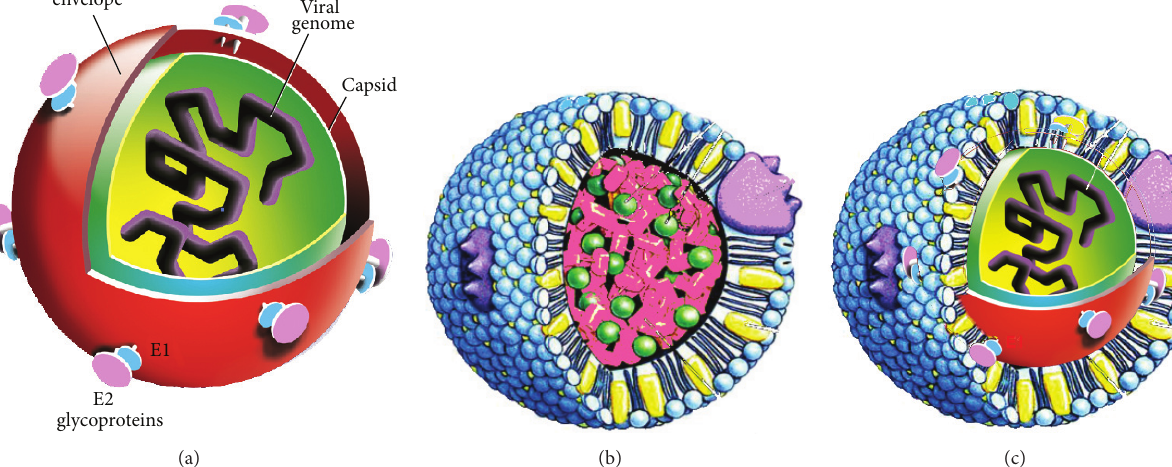
F 1: Schematic representations of the hepatitis C virus. (a) In the absence of three-dimensional structures of the virion or any of its structural proteins (the envelope proteins E1-E2 and the core protein), HCV is represented roughly as a sphere without any symmetry. e E1- E2 glycoproteins (blue and pink, resp.) are set in the viral envelope (red) via their transmembrane domains. eir distribution at the particle surface is le loose on purpose, since currently available high resolution cryo-TEM (transmission electron microscopy) examinations did not show any high-density layer of proteins on the lipid envelope [23, 24]. e internal layer is formed by the core protein (green) compacting the viral RNA genome (black); no structural information is available about the nucleocapsid and its arrangement (illustration by J.-F. Michel). “is research was originally published in [8] .” (b) Structural organization of a lipoprotein. e lipid core is composed of cholesterol esters (pink) and triglycerides (green); it is surrounded by a monolayer of phospholipids (blue), into which free cholesterol molecules are inserted (yellow). Apolipoproteins (purple) are inserted into the lipid layer of this particle. (c) Schematic representation of a lipo-viro-particle (LVP), where HCV nucleocapsid is embedded in the lipid core of the lipoprotein, harboring apolipoproteins and HCV E1-E2 glycoproteins at their